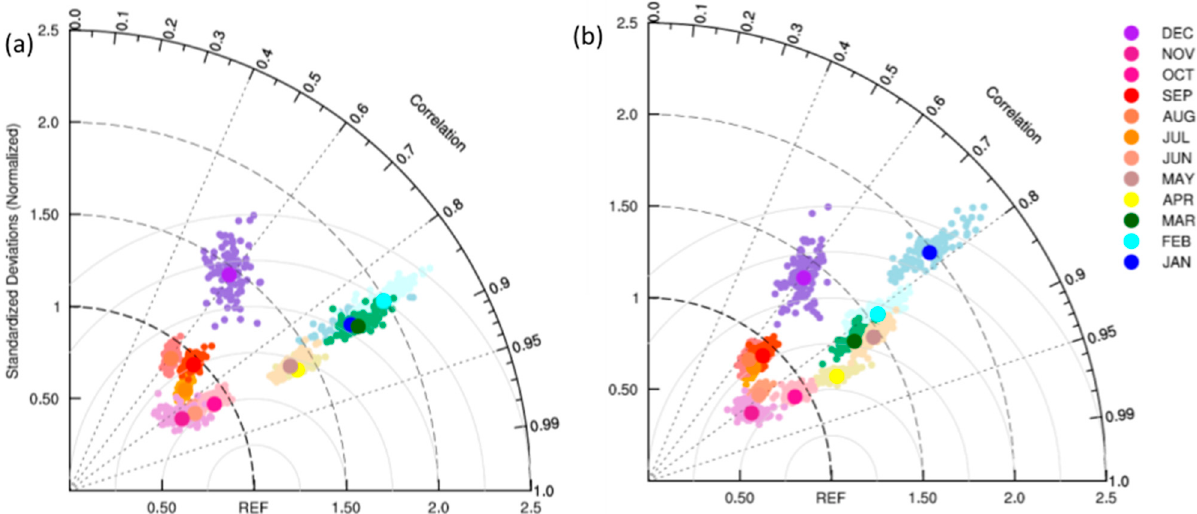
Figure 2. Taylor diagram showing correlations coefficients, standard deviations and RMSEs between AGCM simulations and IMD observation of precipitation for the two climate periods ( a ) 1951–1980 and ( b ) 1981–2010. Dark color marks correspond to the results for ensemble mean and light color marks correspond to each individual member.